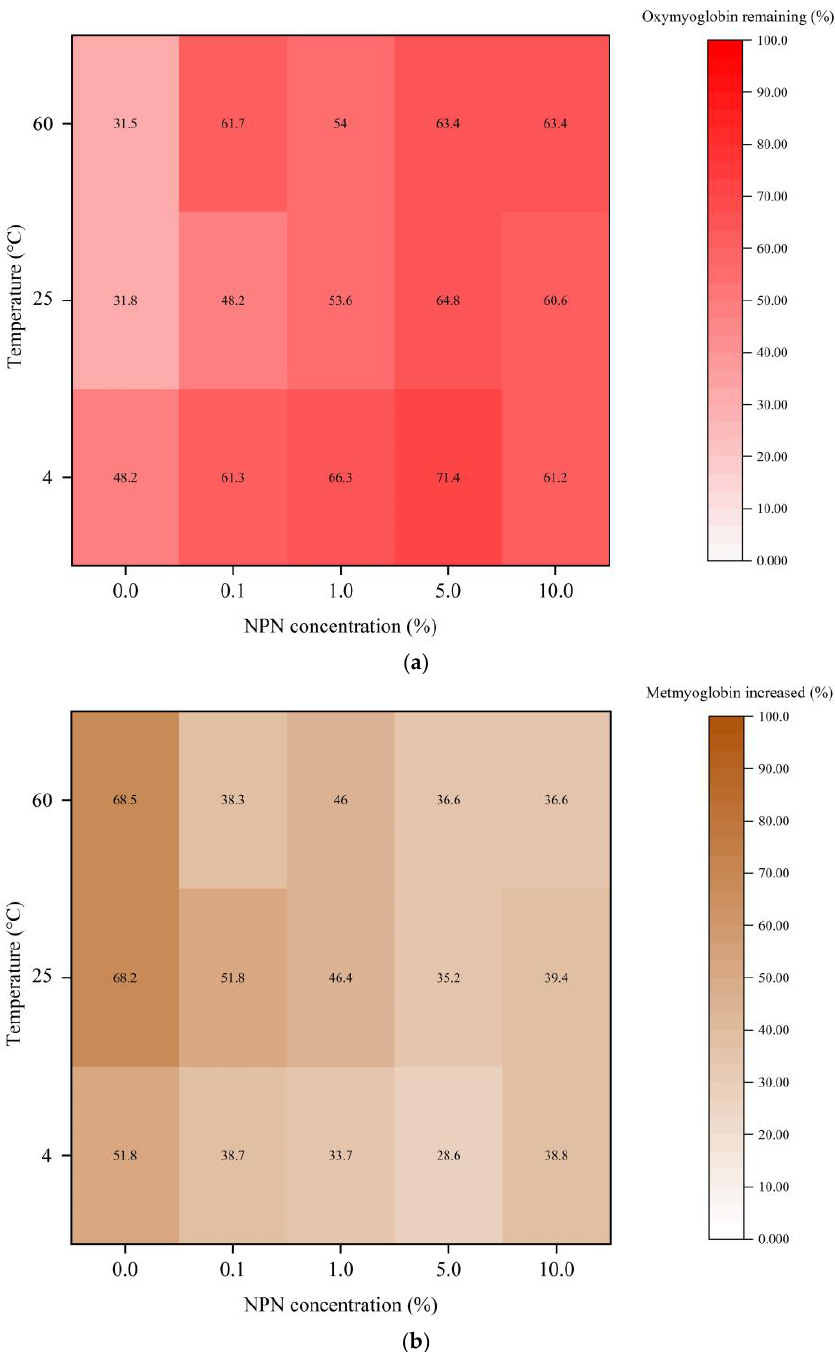
Figure 4. Heat maps of the remaining oxymyoglobin ( a ) and increased metmyoglobin ( b ) of the oxymyoglobin model system added with 0, 0.1, 1, 5, and 10% ( v / v ) of stingray non-protein nitrogen (NPN) incubated at 4, 25, and 60 °C for 120 min. The remaining oxymyoglobin and increased metmyoglobin were calculated in proportion to the initial value (0 min).